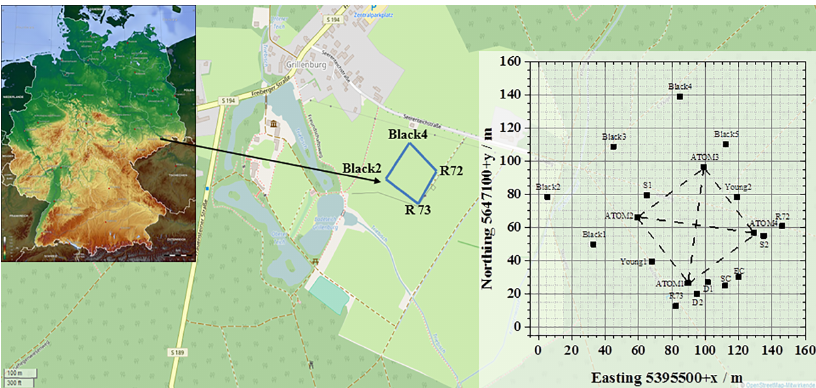
Figure 1. Map of Grillenburg (middle): meadow in light green; Tharandt Forest in dark green; area under investigation is marked by the blue rectangle (mygeo, 2017; openstreetmap, 2017; see references). Scheme of area under investigation with location of several devices and auxiliary equipment: ATOM1–4 (four masts for travel-time tomography A-TOM), dashed lines mark acoustic paths; R72–73 (two Bruker RAPID passive OP-FTIRs); D1–2 and S1–2 (two Bruker EM27 active OP-FTIRs with source and detector); Young1–2 (two masts, each equipped with two ultrasonic anemometers); Black1–5 (five black screens for passive OP-FTIR); EC tower; SC (soil respiration chamber measurements).